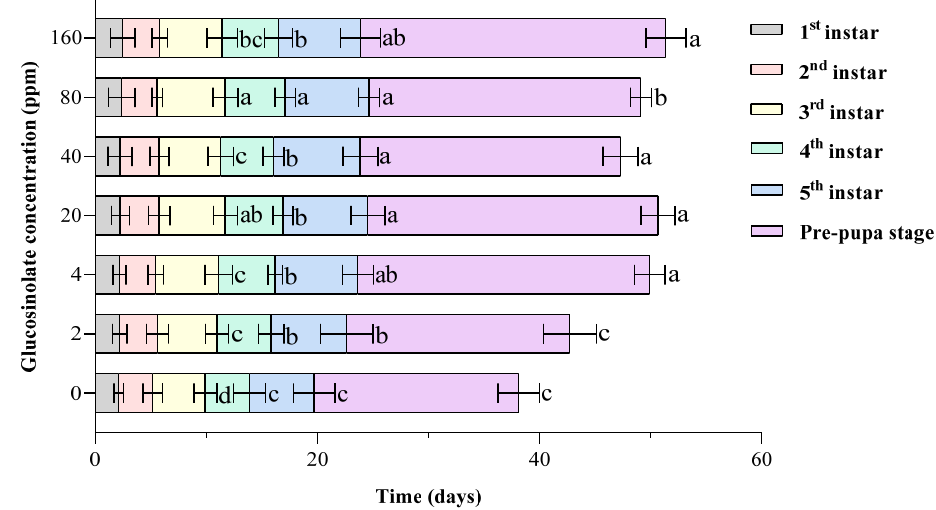
Figure 1. Growth and development of cotton bollworm larvae. The development period of the H. armigera at different instars under different concentrations of glucosinolate. Error bars indicate standard errors of the means (SE) ( n = 100). Letters indicate values that are statistically different from the control group ( p < 0.05).